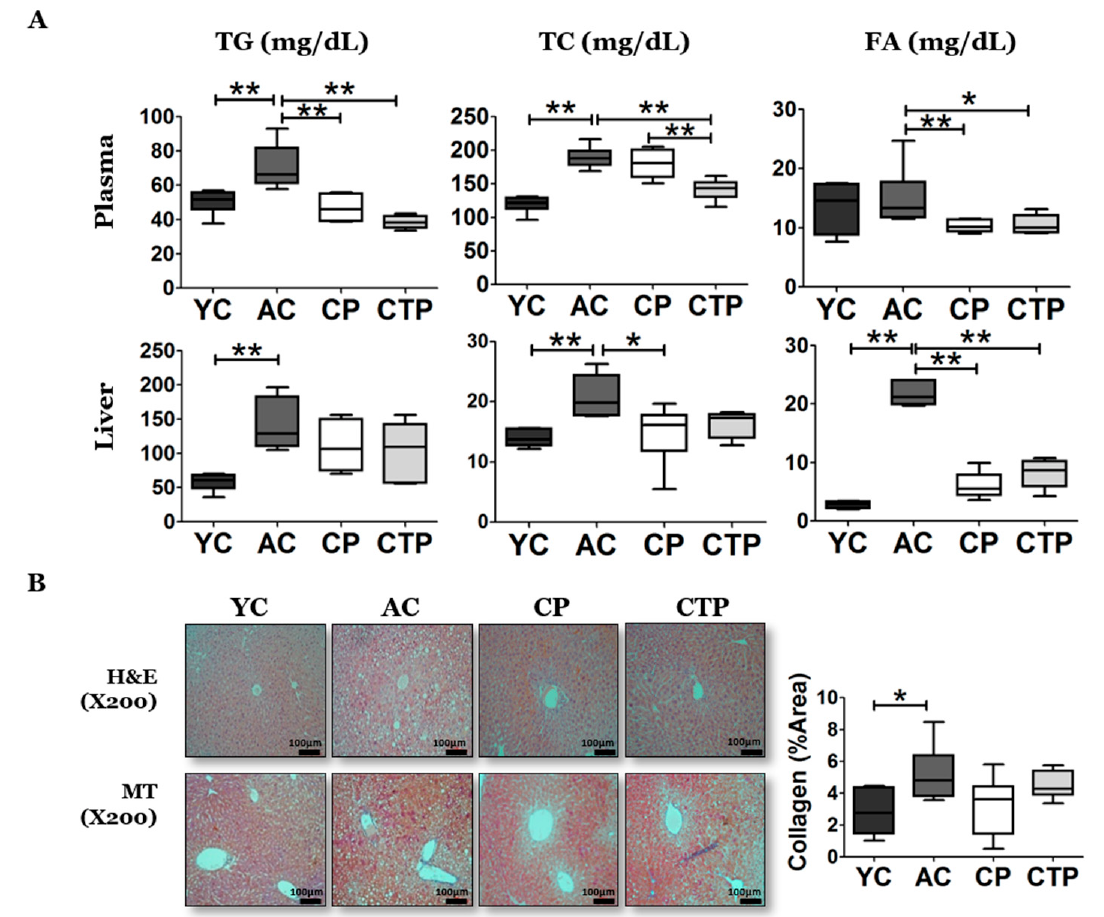
Figure 4. Effect of a 12-week supplementation of CP and CTP on antioxidant metabolism and G6P enzyme activity. ( A ) Cytokine levels. TNF- α , tumor necrosis factor alpha; IL, interleukin. ( B ) Catalase (CAT), glutathione (GSH), GR, glutathione peroxidase (GSH-Px), superoxide dismutase (SOD), and paraoxonase (PON) activities in plasma, erythrocytes, and hepatic tissueData are mean ± SE. Significant differences are indicated as follows: * p < 0.05, and ** p < 0.01. YC, young mice control (12 weeks old, n = 6); AC, aging control (60 weeks old, n = 6); CP, collagen peptide (60 weeks old, n = 6); CTP, collagen tripeptide (60 weeks old, n = 6).